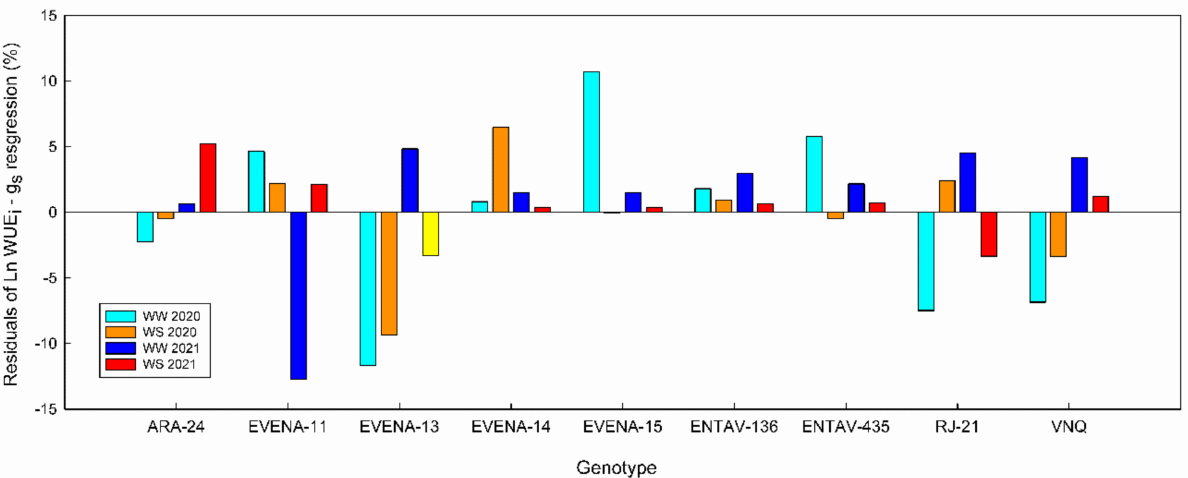
Figure 3. Residuals of the water use efficiency over stomatal conductance (WUE i –g s ) linearized regression for each “Grenache” genotype. Well-watered 2020 (cyan); water stress 2020 (orange); well-watered 2021 (blue); water stress 2021 (red).